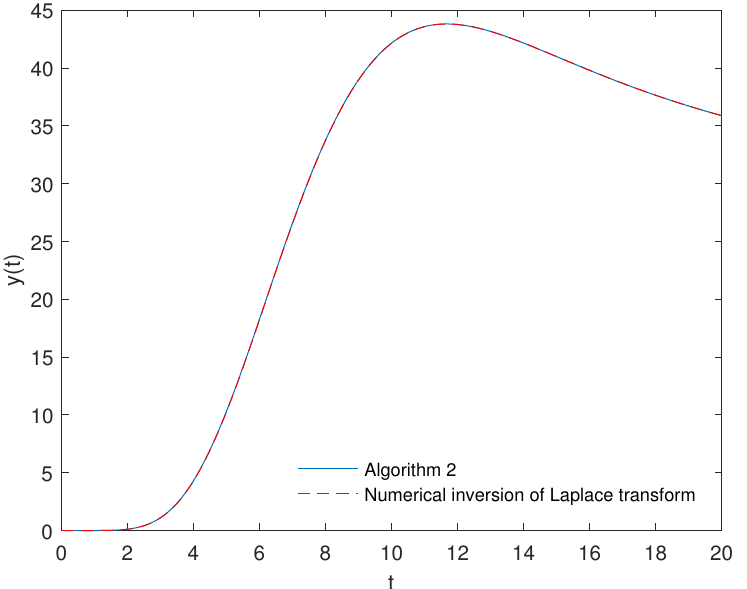
Algorithm 2 Numerical inversion of Laplace transform